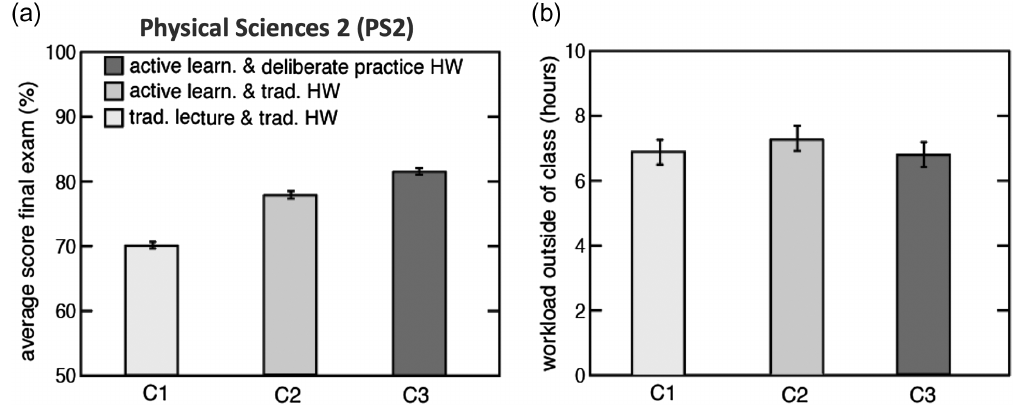
FIG. 2. Measurement of the (a) average percentage score for the 3-h comprehensive examination and (b) average workload (measured in hours) outside of class, for three cohorts of students over three consecutive years. The first cohort (C1) received a traditional treatment for the lecture and homework portions of the course. The second cohort (C2) experienced a change in lecture with the introduction of active learning but maintained the same traditional homework as C1. The third cohort (C3) received the transformed homework (deliberate practice HW) as well as the active learning in lectures. Error bars on both plots show 1 SE.